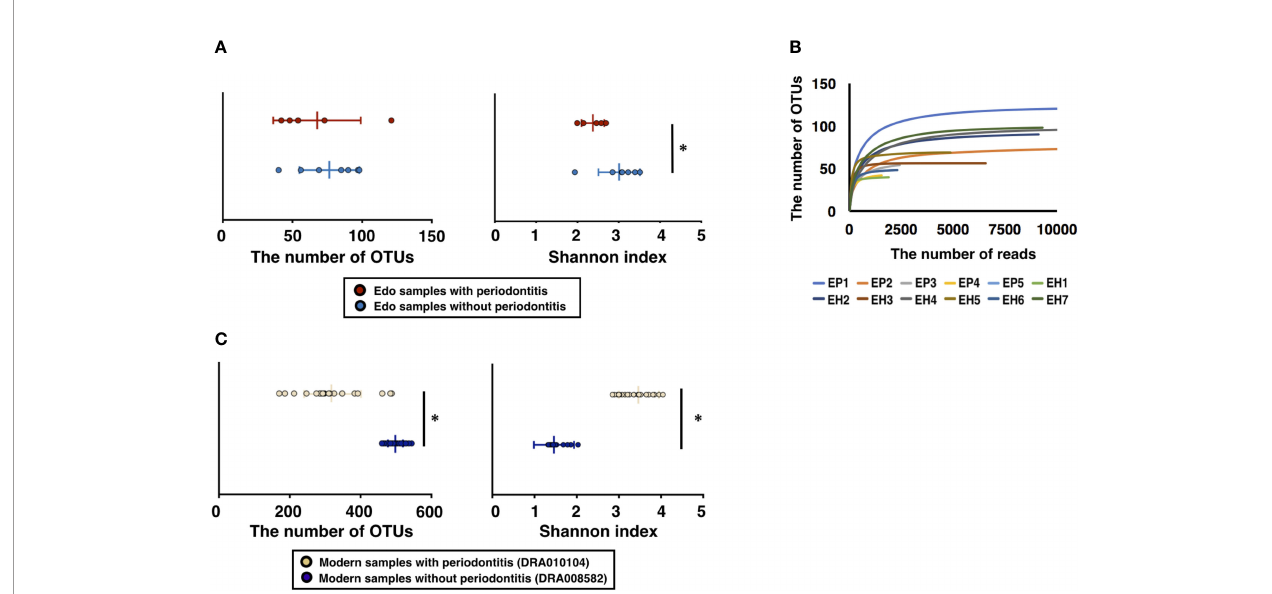
FIGURE 2 | Evaluation of bacterial diversity of ancient Edo sample based on 16S rDNA sequences. (A) The number of operational taxonomic units (OTUs) and Shannon index of Edo samples. (B) Rarefaction curve of Edo samples. (C) The number of OTUs and Shannon index of modern samples. *P < 0.05.